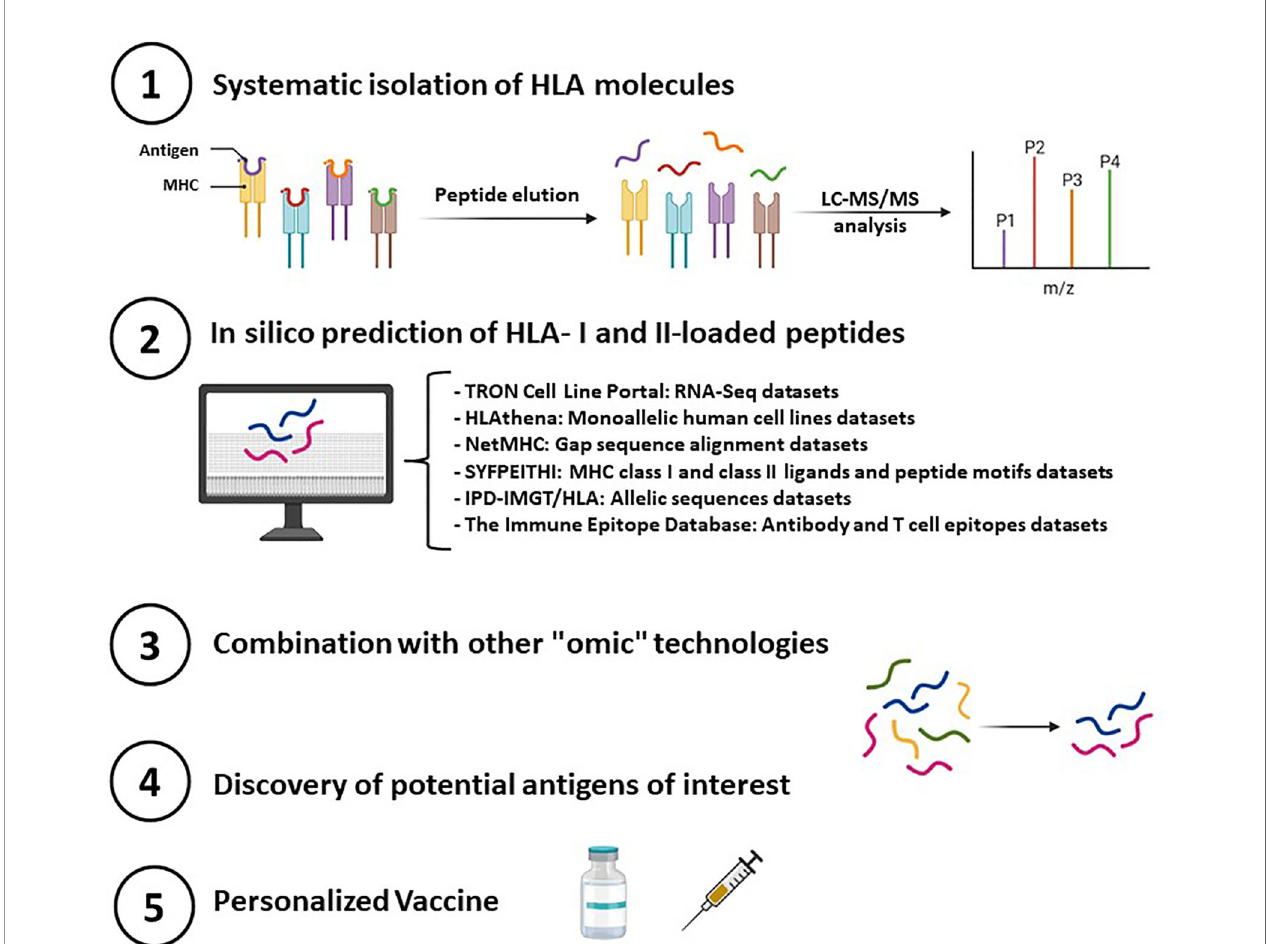
FIGURE 3 | Essential steps in deciphering immunopeptides that elicit a T-cell response and therefore serve to design personalized peptide